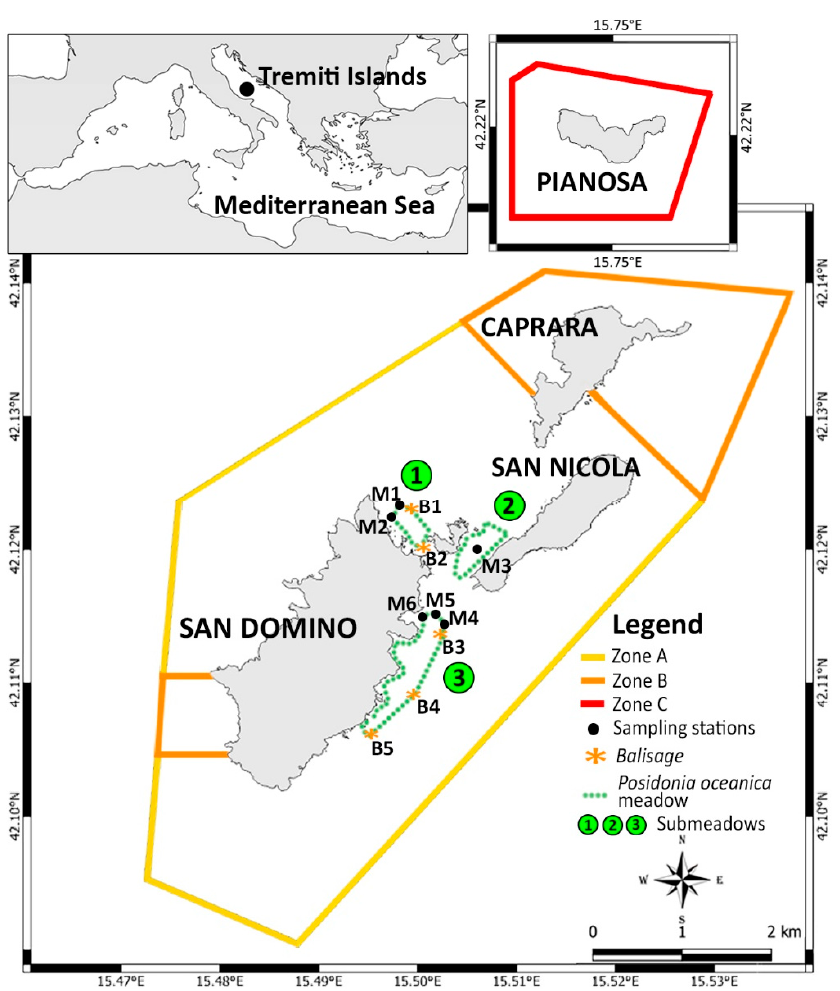
Figure 1. Map of the study area showing the sampling stations (M1–M6), the balisage sites (B1–B5), and the general distribution of P. oceanica meadow. Zone A (no take, no entry area, 12 nautical miles away from the three main islands), Zone B (highly protected area), and Zone C (partially protected area).